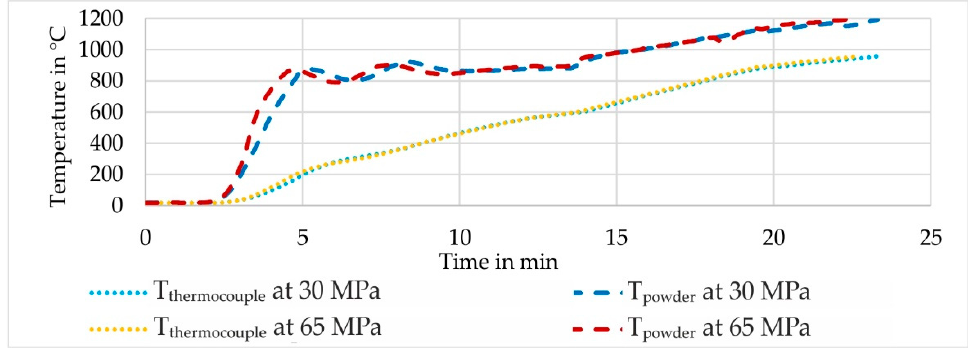
Figure 3. Temperature–time diagram of TNM to determine correction factors. Figure 2. Temperature–time diagram of GE48 to determine correction factors. Figure 2. Temperature–time diagram of GE48 to determine correction factors.